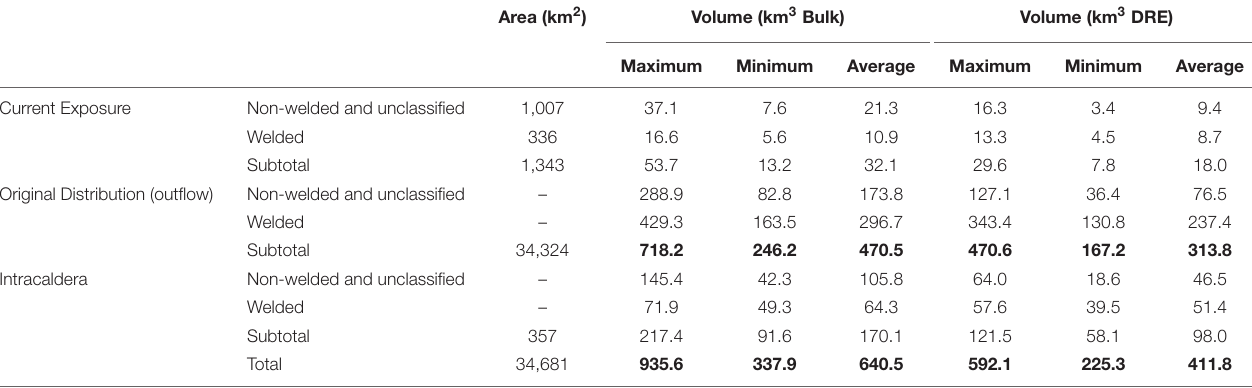
TABLE 1 | Results of the area and volume estimation of Aso-4 PDC deposit (density of the non-welded and unclassified facies is 1,100 kg/m 3 , welded facies is 2,000 kg/m 3 , and dense rock is 2,500 kg/m 3